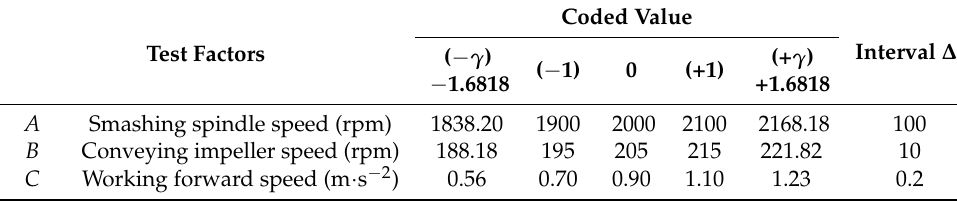
Table 2. Factors and levels of virtual test.